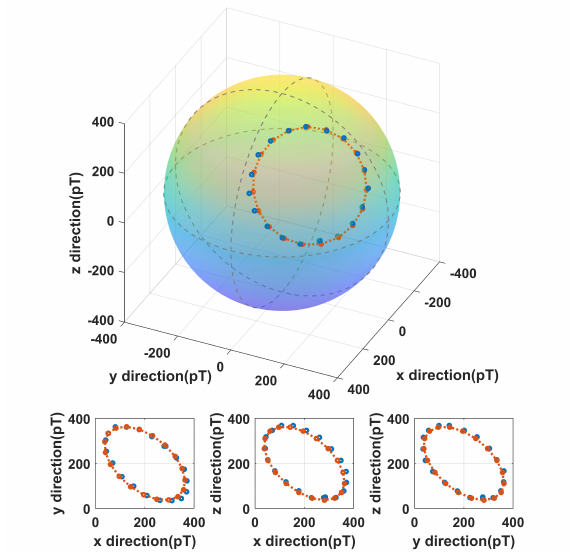
Figure 5. Comparison of the experimental and expected values when measuring magnetic fields of various orientations. Red dots present the expected values of applied magnetic fields, and blue dots present the values recorded by the vectorial AM. The projections of each dot on each coordinate plane are also presented.